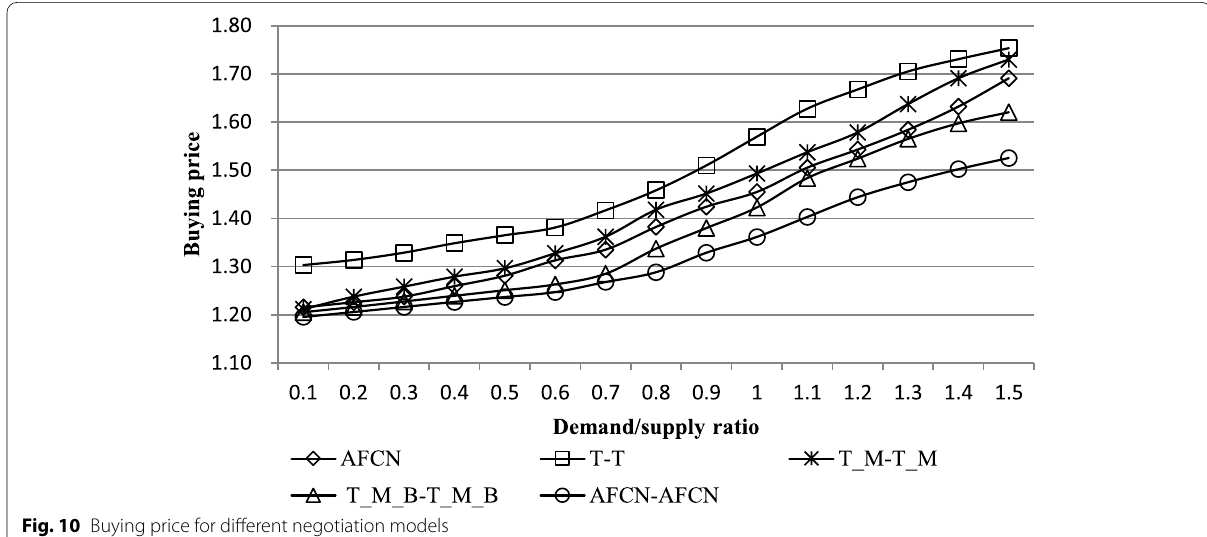
Fig. 10 Buying price for different negotiation models